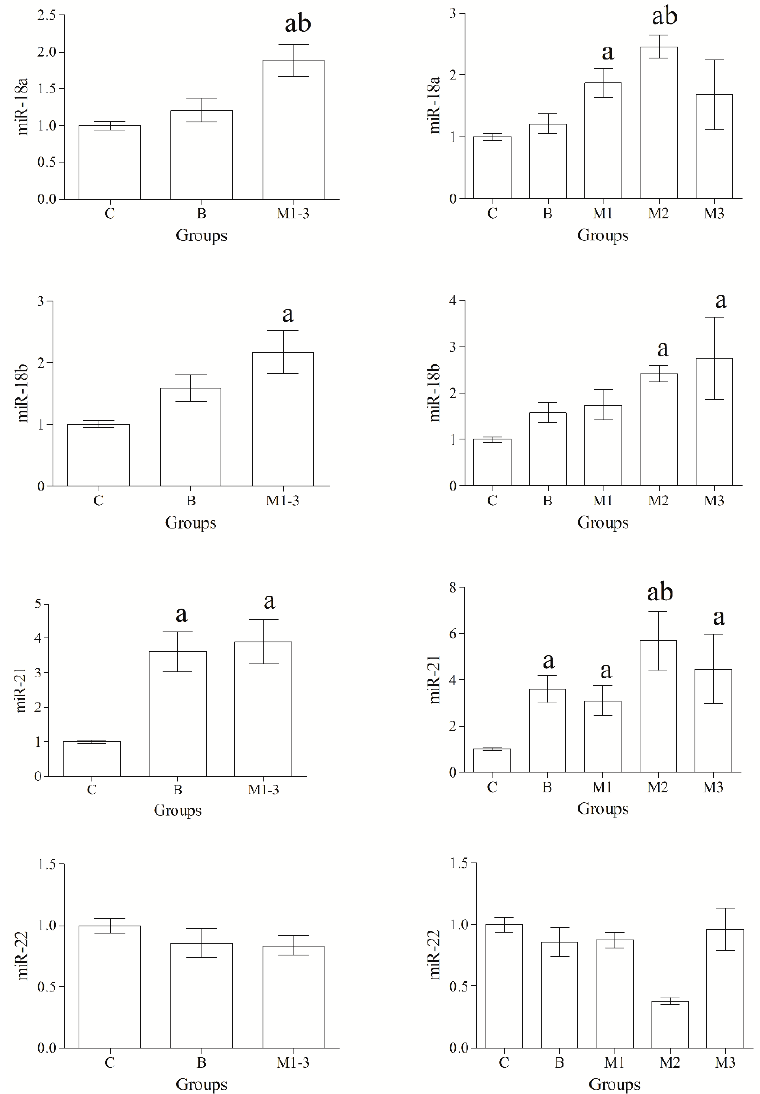
Figure 1. Expression levels of miR-18a, miR-18b, miR-21, miR-22. MiR-18a, miR-18b and miR-21 were upregulated in malignant tumors (M1-3) compared with the control group (C). The expression level of miR-18a and miR-21 was significantly upregulated in malignant neoplasms compared with benign tumors (B). Significances ( p < 0.05): a vs. Group C, b vs. Group B.